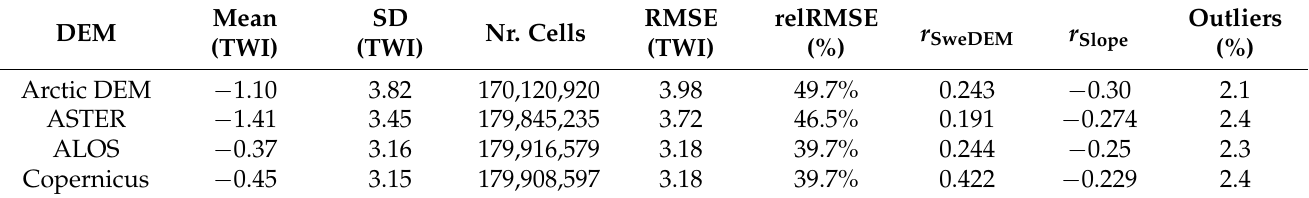
Table 5. Overall statistics of TWI errors for four candidate